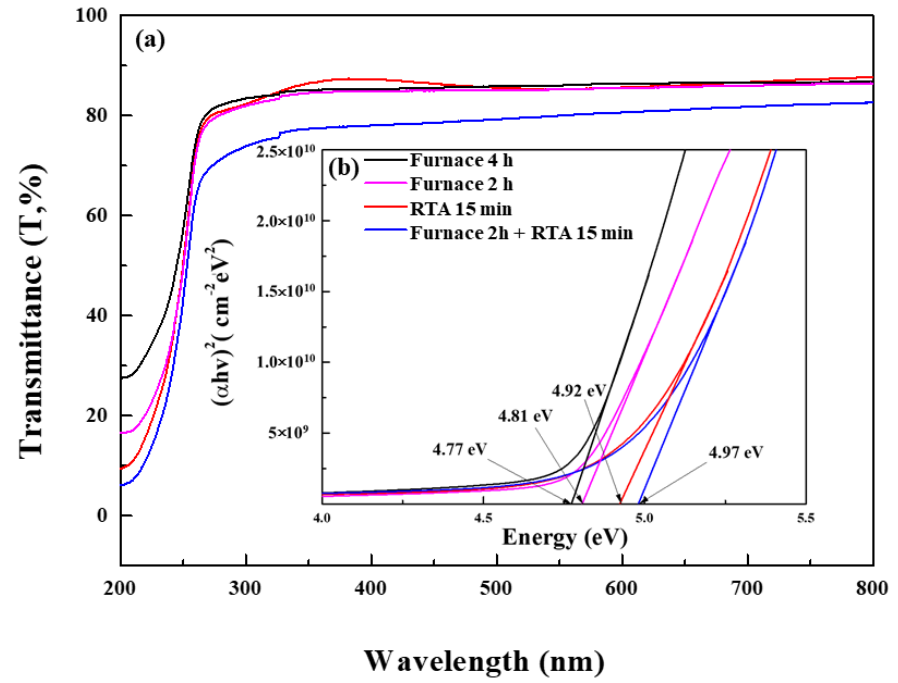
Figure 7. ( a ) Transmittance spectra and ( b ) Tauc plots of β -Ga 2 O 3 thin films prepared at 900°C